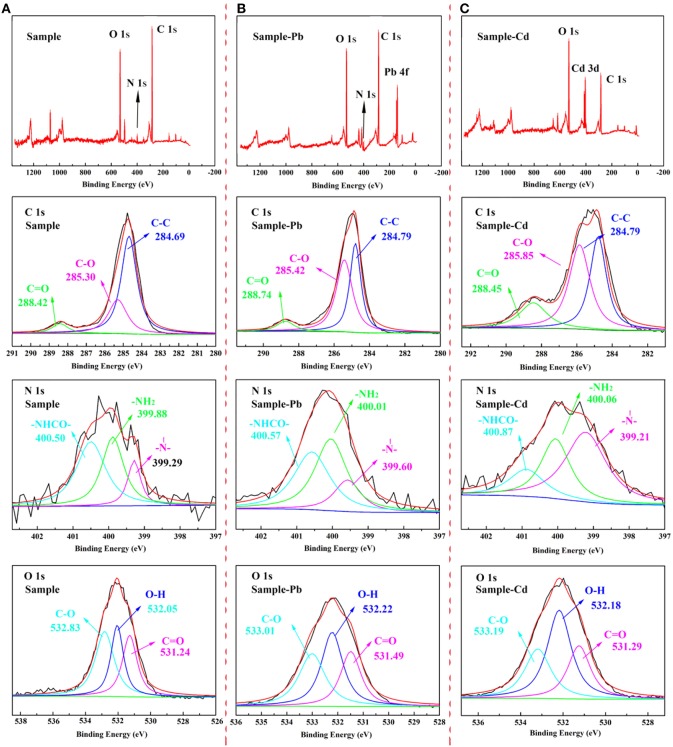
The XPS spectra of CMC-g-PAM/MMT before (A) and after (B) Pb2+, (C) Cd2+ adsorption.